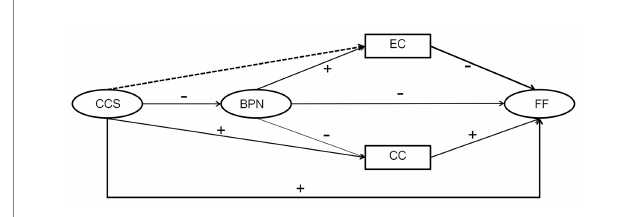
FIGURE 1 Hypothetical model of the relationship between CCS and FF. CCS, controlling coaching style; BPN, basic psychological need; CC, constrained commitment; EC, enthusiastic commitment; FF, fear of failure. The positive sign between CCS and FF indicates that CCS positively affects FF, thus higher levels of CCS are associated with more FF. The minus sign indicates between CCS and BPN indicates that CCS negatively affects BPN, thus higher levels of CCS are associated with less BPN. The minus sign indicates between BPN and FF indicates that BPN negatively affects FF, thus higher levels of BPN are associated with less FF. a CCS can predict athletes’ FF through BPN. The more CC were perceived to be, the lower athletes’ BPN, leading to a stronger FF. The positive sign between CCS and CC indicates that CCS positively affects CC, thus higher levels of CCS are associated with more CC. The positive sign indicates between CC and FF indicates that CC positively affects FF, thus higher levels of CC are associated with more FF and CCS can predict athletes’ FF through CC. The more CCS were perceived to be, the stronger the CC, leading to a stronger FF. The dotted line between CCS and EC indicates that no assumption was made on the relationship between CCS and athletes’ EC, because it has not been clarified before. The minus sign indicates between EC and FF indicates that EC negatively affects FF, thus higher levels of EC are associated with less FF. The positive sign between BPN and EC indicates that BPN positively affects EC, thus higher levels of BPN are associated with more EC. The minus sign indicates between BPN and CC indicates that BPN negatively affects CC, thus higher levels of BPN are associated with less CC. BPN had a chain mediating effect on CC, mediated by a CCS and athletes’ FF, The more controlling their coaches were perceived to be, the lower athletes’ BPN and the stronger the CC, leading to a stronger FF. The chain mediating effect of BPN and EC has not yet been hypothesized, because it has not been clarified